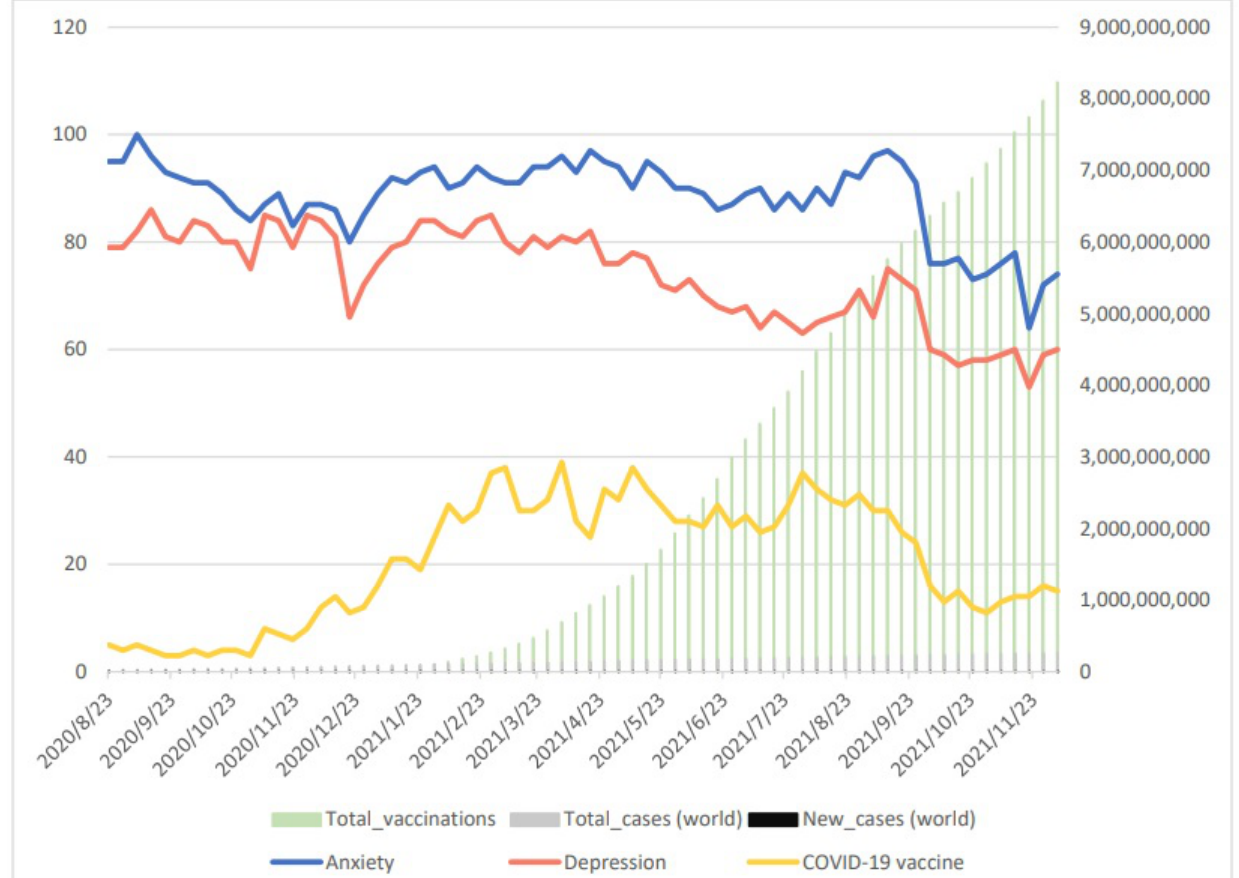
Figure 3. Display of Google Trend data for COVID-19 vaccines, anxiety, and depression as well as for total and new COVID-19 cases. *Normalized search data were obtained from Google Trend (100—high interest; 0—no or insufficient interest data) for the period from 23 August 2020 to 5 December 2021. COVID-19 case data were from JHU (John Hopkins University) CSSE COVID-19 Data (accessed on 5 December